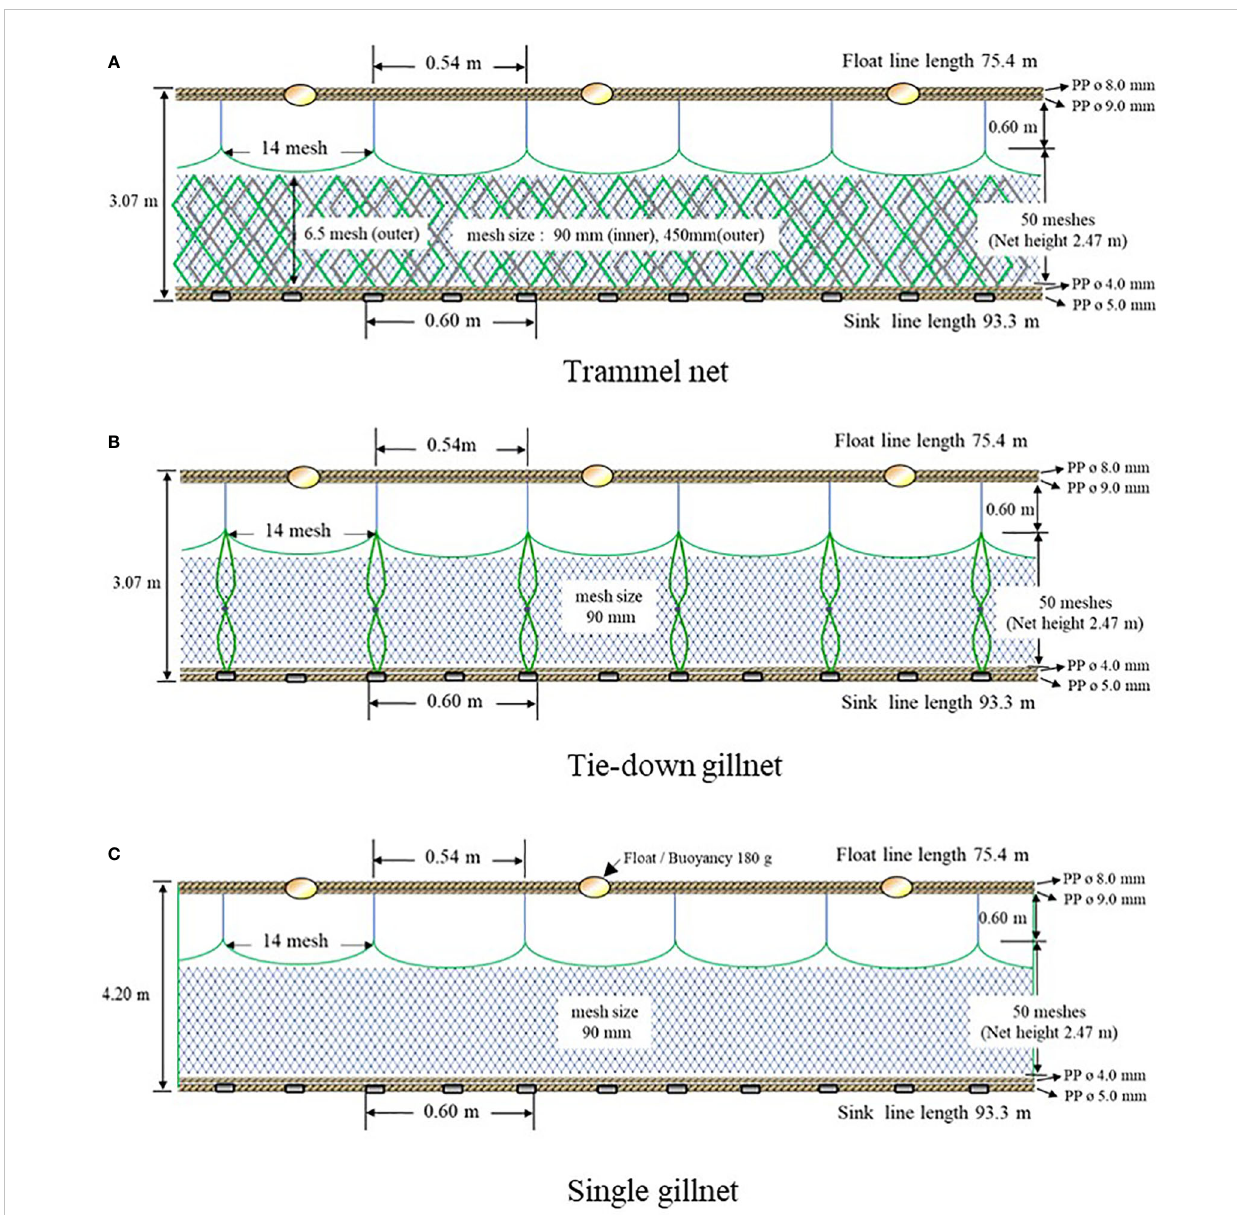
FIGURE 2 Construction of the experimental gillnets for black fi n fl ounder used in the sea trials; (A) trammel net, (B) tie-down gillnet, and (C) single